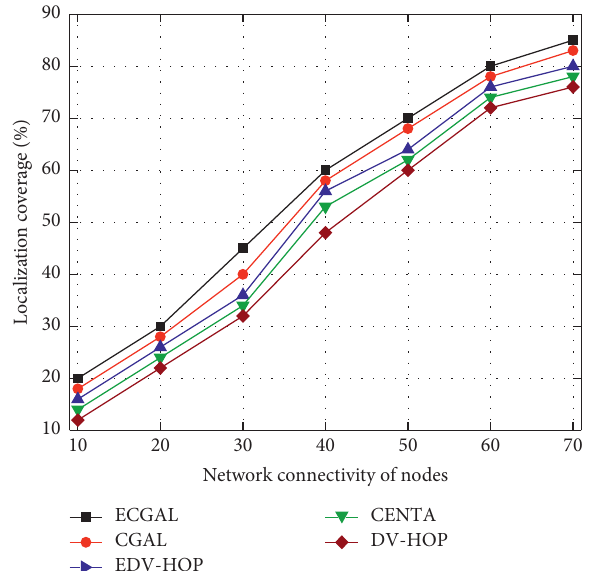
Figure 15: The success rate of packets against the number of